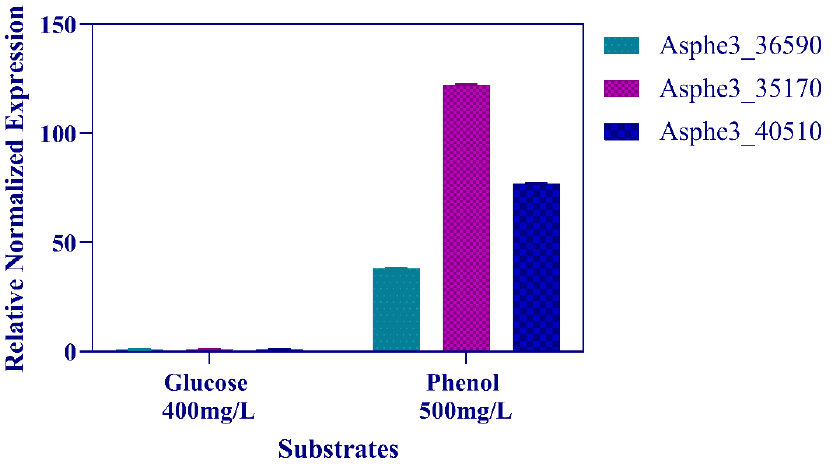
Figure 3. Asphe3_36590, Asphe3_35170, and Asphe3_40510 transcription quantification monitored by RT-qPCR in Sphe3 grown on glucose and phenol, each as the sole carbon and energy source. Values represent the mean relative gene expression normalized to the housekeeping gene gyr β ± standard deviations of three individual replicates. Gene expression levels in glucose were used as a calibrator.